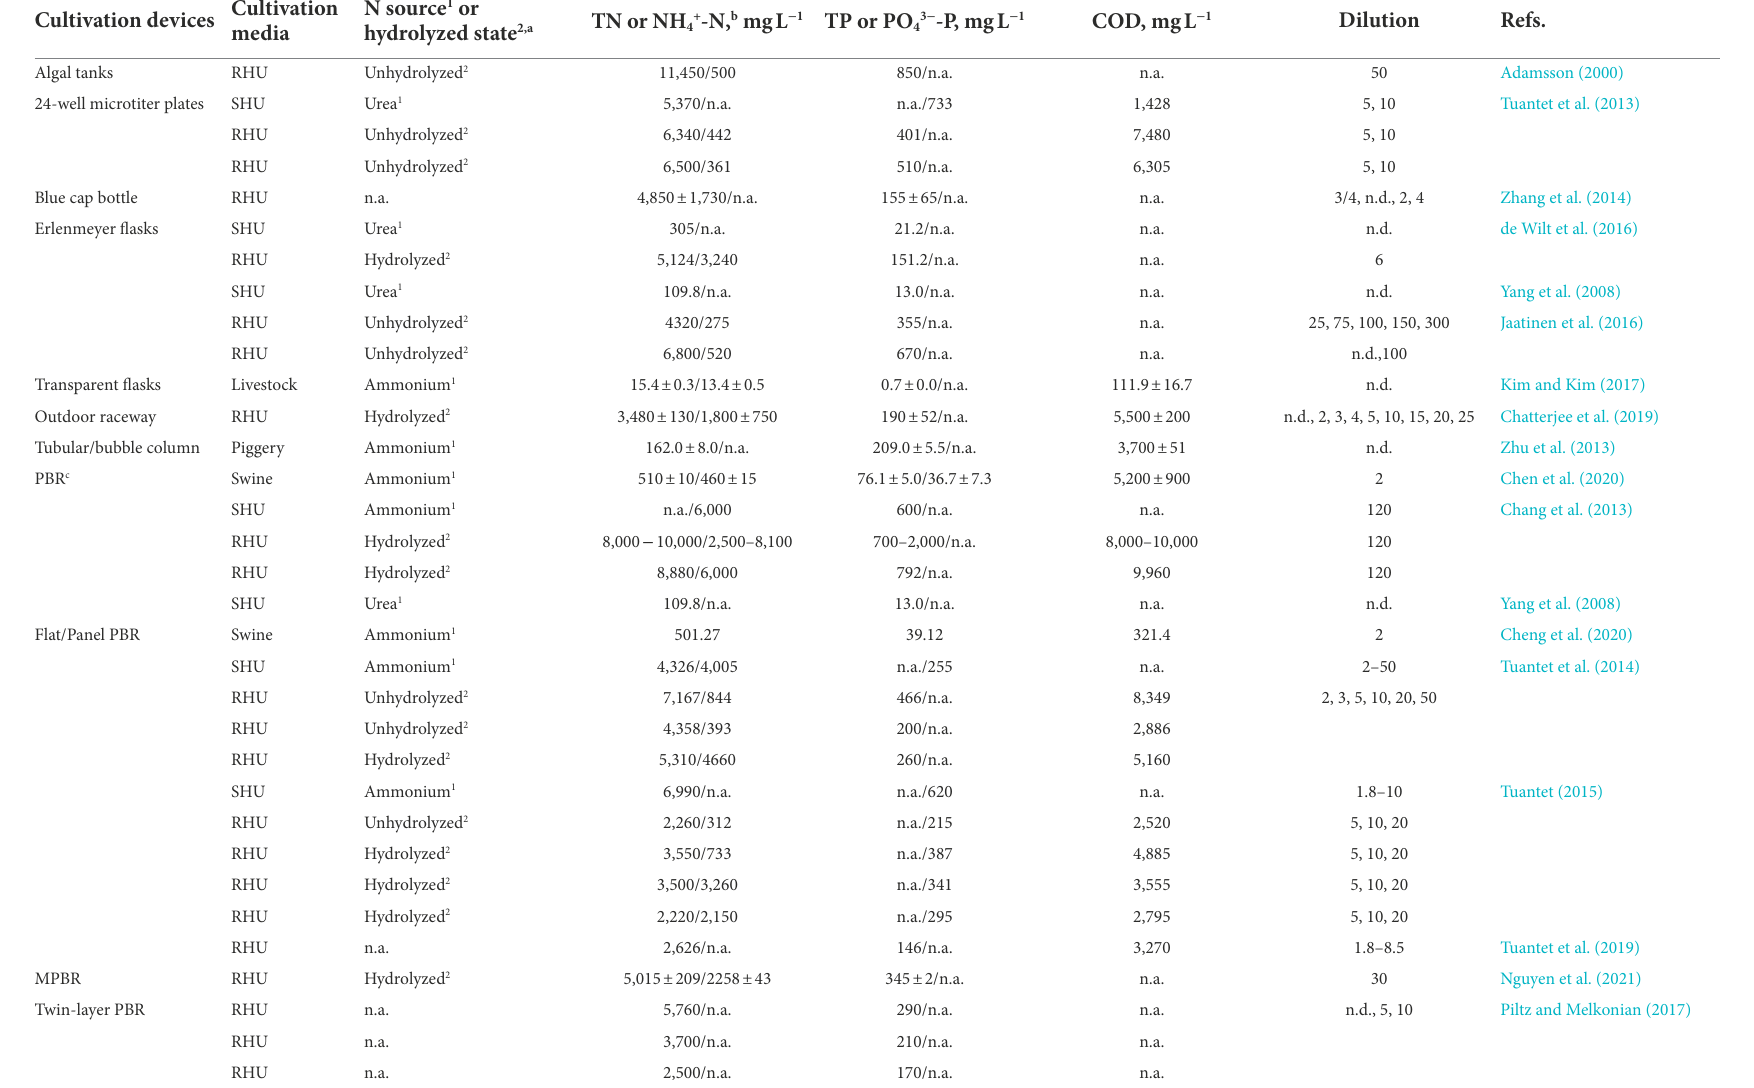
TABLE 1 Compositions of cultivation media used for